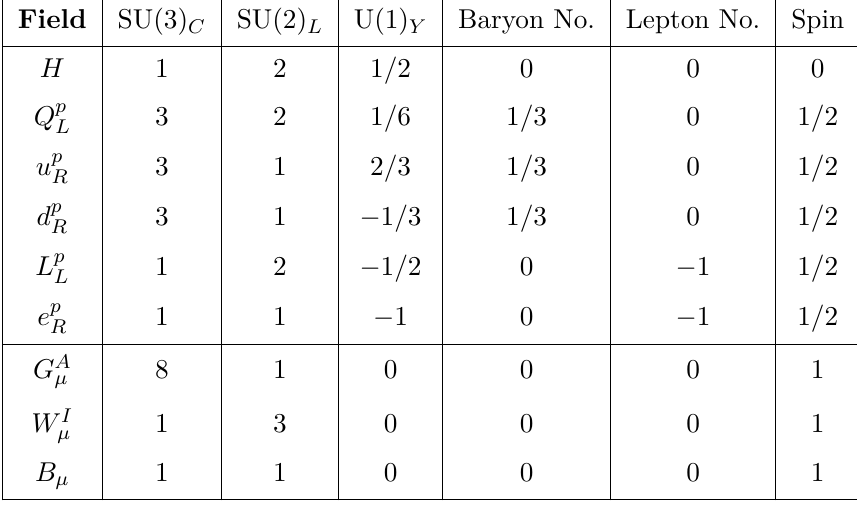
Table 29 . Standard Model: gauge and global quantum numbers and spins of the fields. the operators in their covariant forms, we have to be careful with the quadruplet Θ . That is why we have worked with its component form Θ with i, j, k = 1 , 2 and we identify the ijk components as Θ = Θ +++ , Θ = Θ ++ , Θ = Θ + and Θ = Θ 0 . To compute the 111 112 122 222 higher tensor products of Θ with the SU(2) doublets, i.e., L, Q, H and with the triplet L W , we have introduced the 4 × 4 generators of SU(2) and we denote them as τ I µν (4)